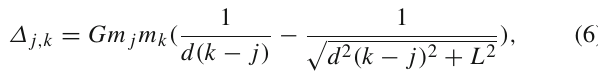
Fig. 1 Schematic representation. The direction of the separation between each particle is orthogonal to the direction of the separation of the particle with its superposed position. a One-side model: The j -th particle from the left (0 ≤ j ≤ n ) has mass m j . The particles interact with one another through gravity. b Two-side model: the subscripts “ l ”